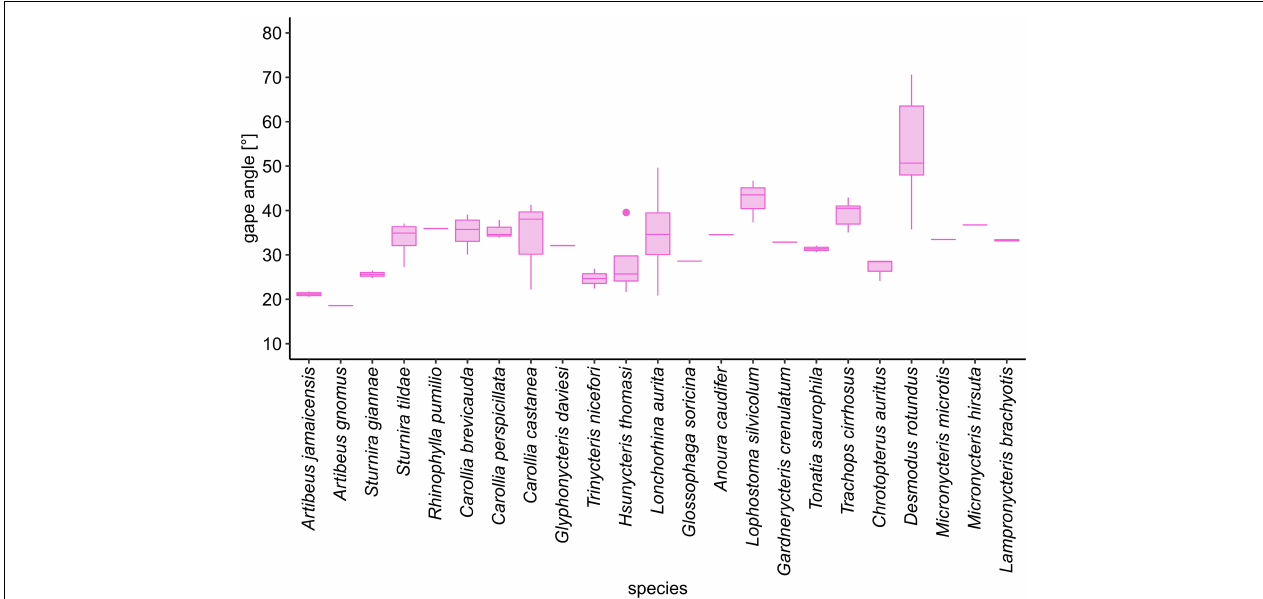
FIGURE 4 | Gape angle of 23 phyllostomid species. Desmodus rotundus had the widest gape angle (54 ◦ ± 12.1 ◦ ) while Artibeus gnomus (19 ◦ ) opened the mouth only slightly during flight. The box incorporates the middle 50% of the data and the line within the box the median value. Whiskers mark the 25th percentile and the 75th percentile of the data (range of the data). Outliers are plotted as dots (values that are more than 1.5 times the interquartile range beyond either end of the